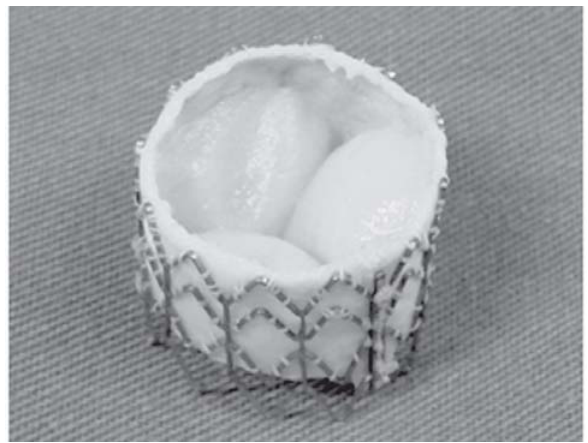
Fig. 1 – Modelo final de bioprótese aórtica para montagem em cateter sobre